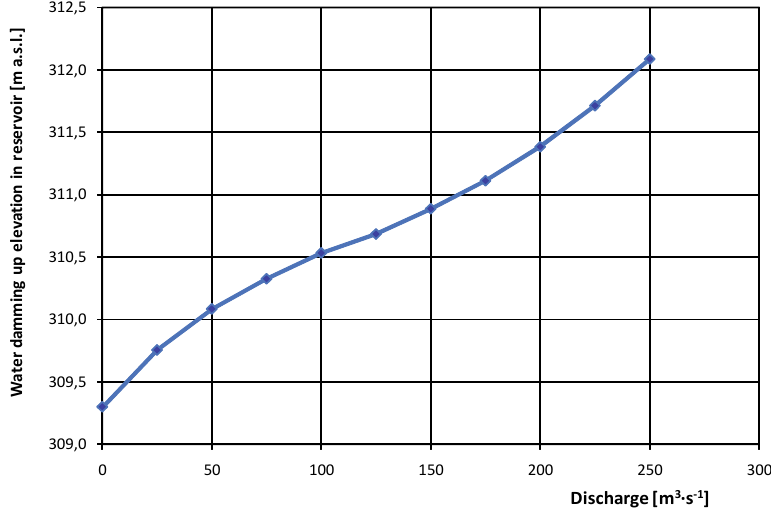
Fig. 3. Hydraulic characteristics of side channel spillway at Złotniki reservoir for the existing state